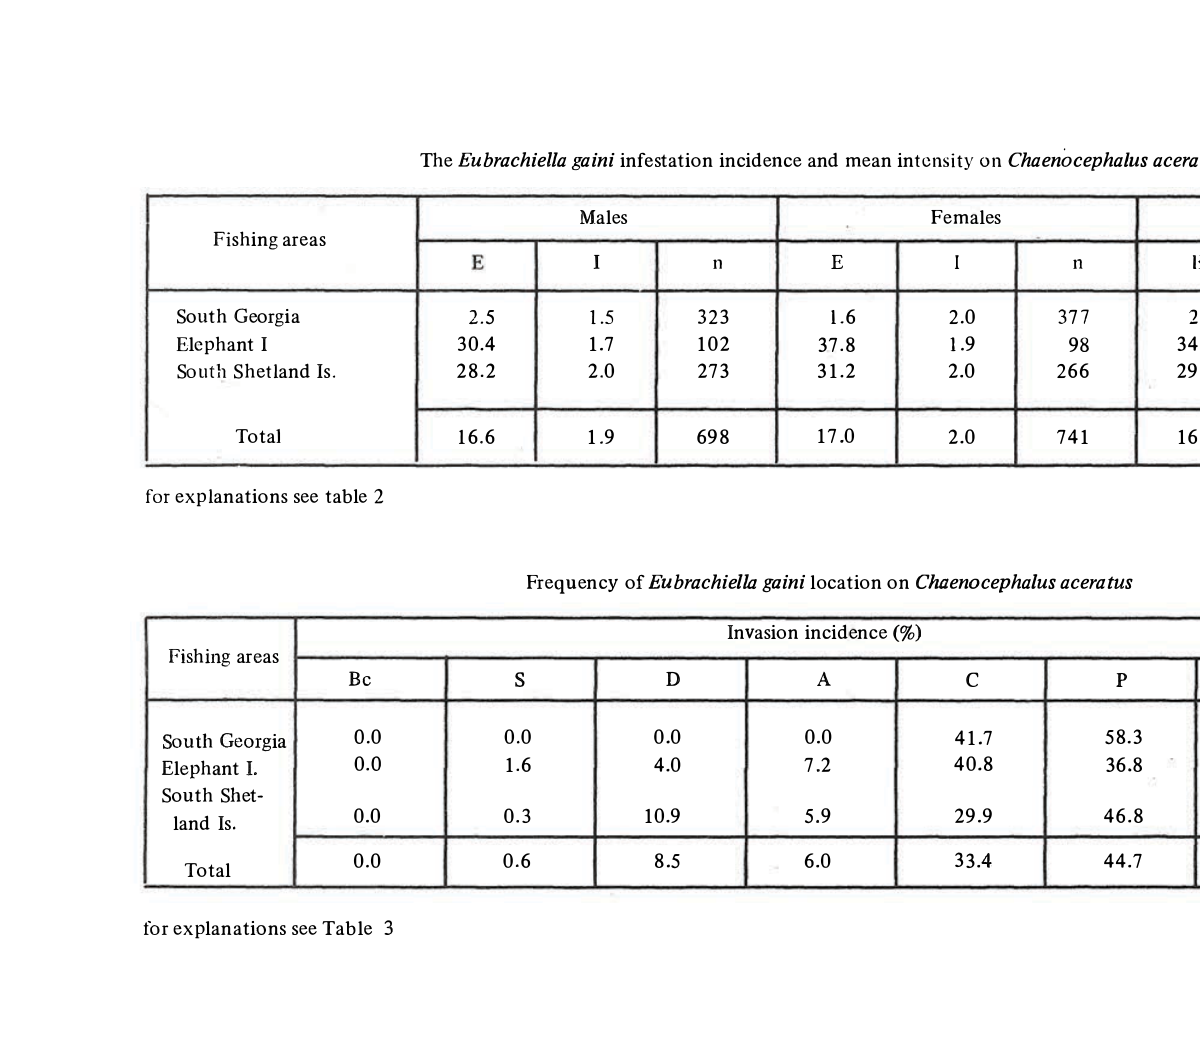
Frequency of Eubrachiella gaini location on Chaenocephalus